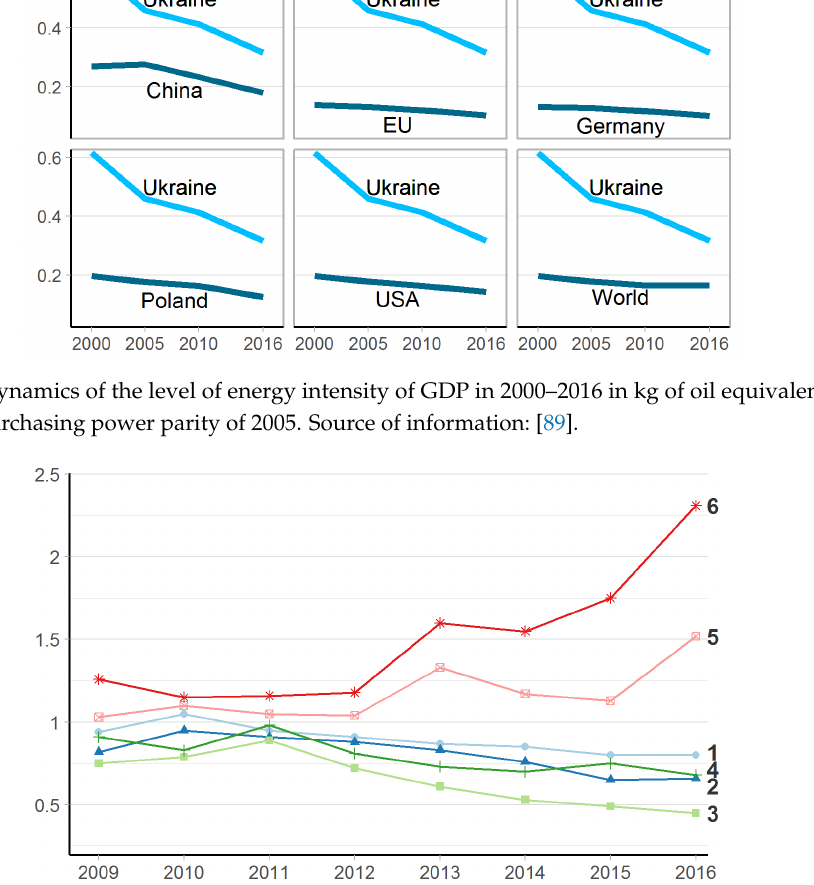
Figure 9. Dynamics of the structure of energy consumption in Ukraine by types of energy resources in percentages. Source of information: [88].